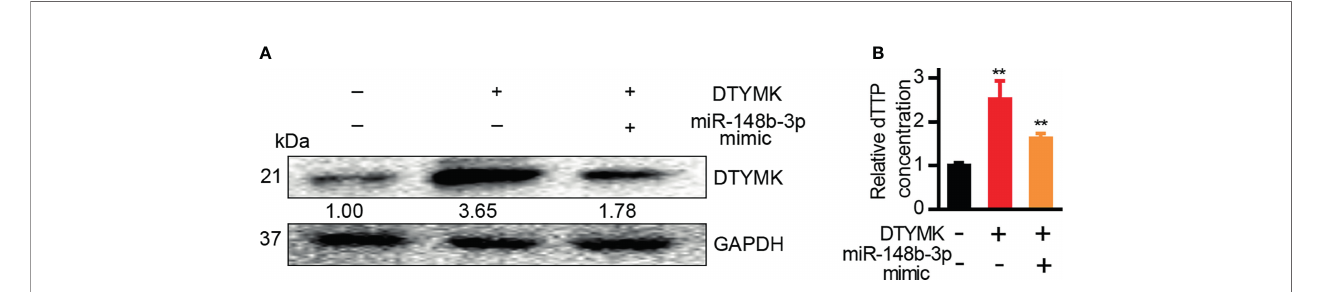
FIGURE 6 | MiR-148b-3p suppression of DTYMK expression regulates intracellular dTTP levels. (A) DTYMK protein levels in cells transfected with miRNA-148b-3p mimics or/and DTYMK overexpression constructs. (B) Relative dTTP levels in cells transfected with miRNA-148b-3p mimic or/and DTYMK overexpression vectors **p < 0.01; Student ’